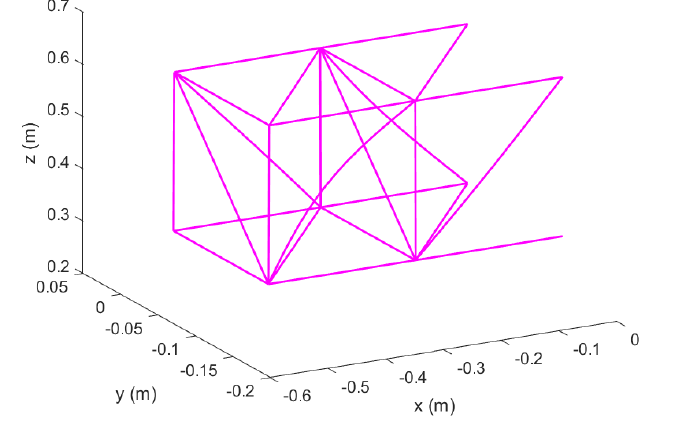
Figure 42. Mode 3 of Timoshenko beams in Topology 2 with hinged ends; original